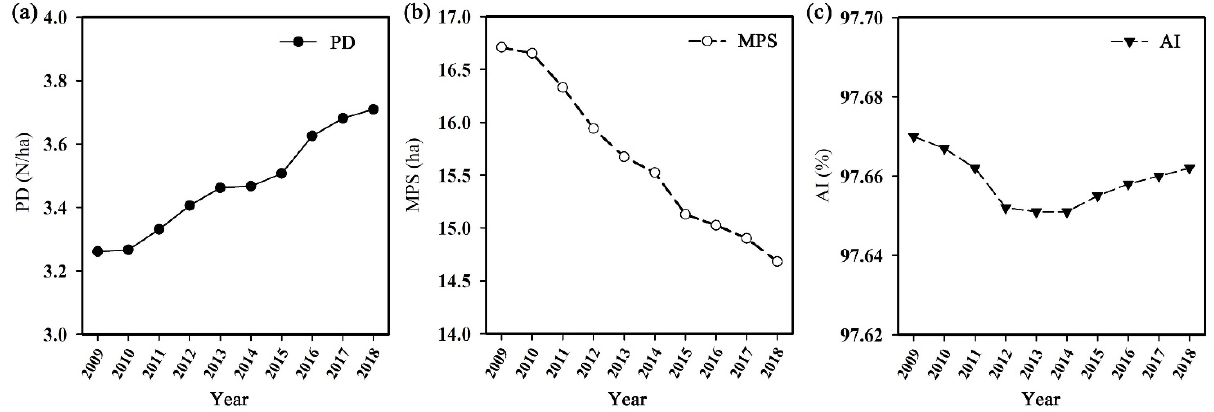
Figure 5. Changes in the PD ( a ), MPS ( b ), and AI ( c ) of farmland in Sihong from 2009 to 2018.